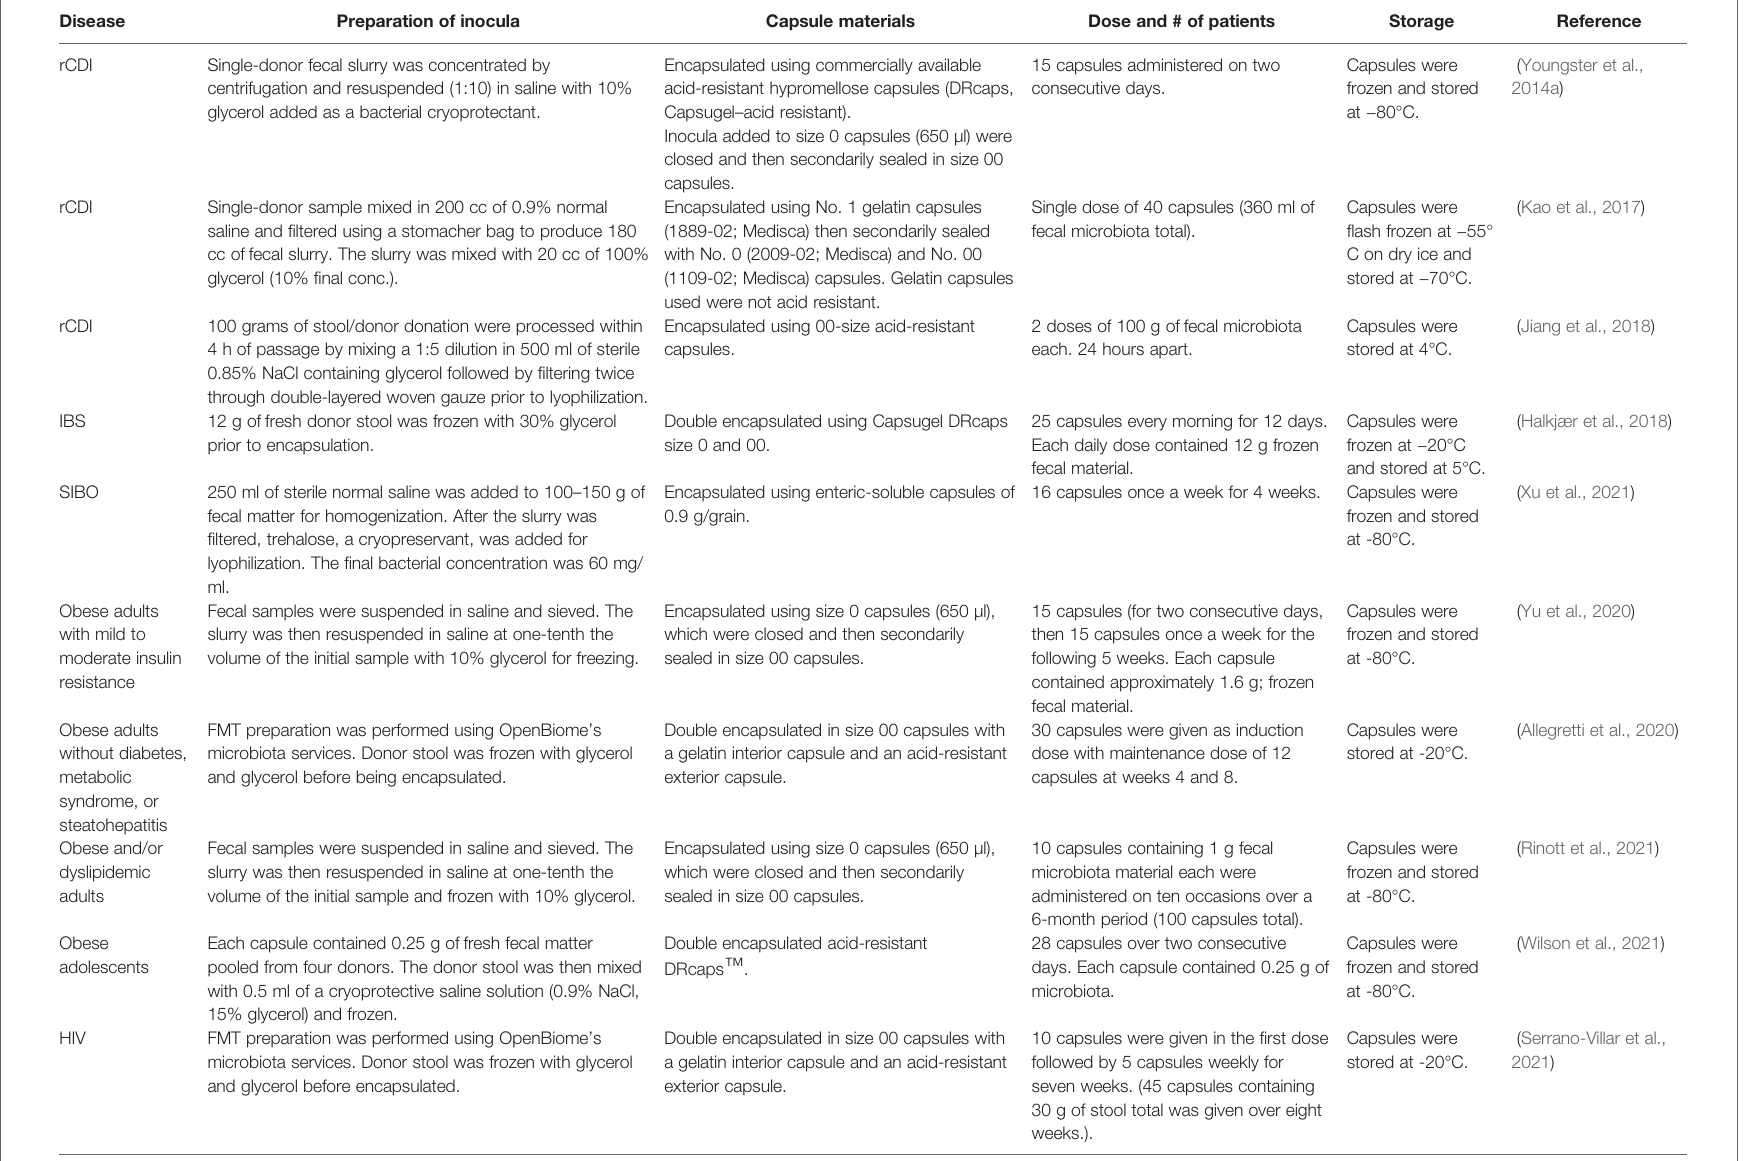
TABLE 2 | Summary of published cFMT preparation